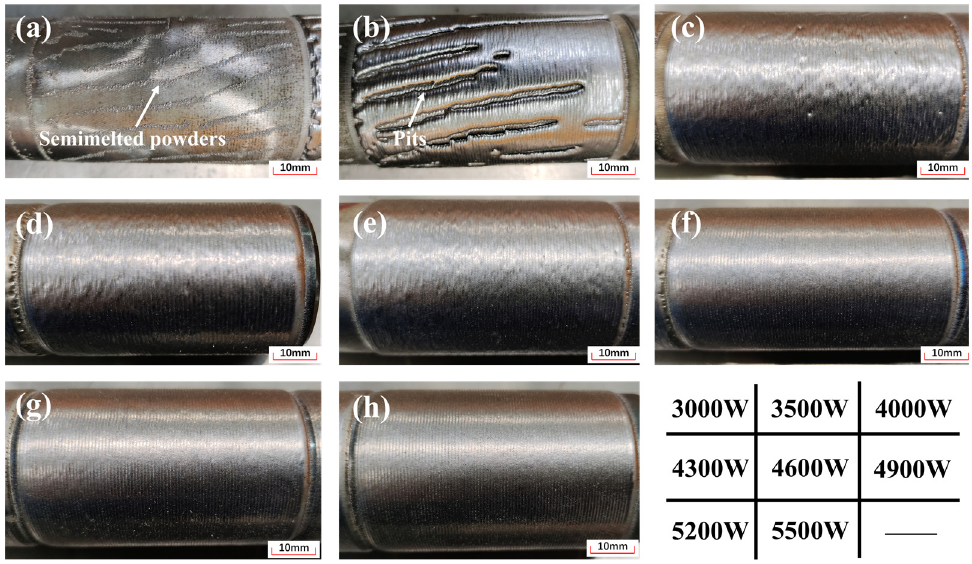
Figure 14. Macro-morphologies of EHLA coatings under different laser powers. ( a ) 3000 W; ( b ) 3500 W; ( c ) 4000 W; ( d ) 4300 W; ( e ) 4600 W; ( f ) 4900 W; ( g ) 5200 W; ( h ) 5500 W.